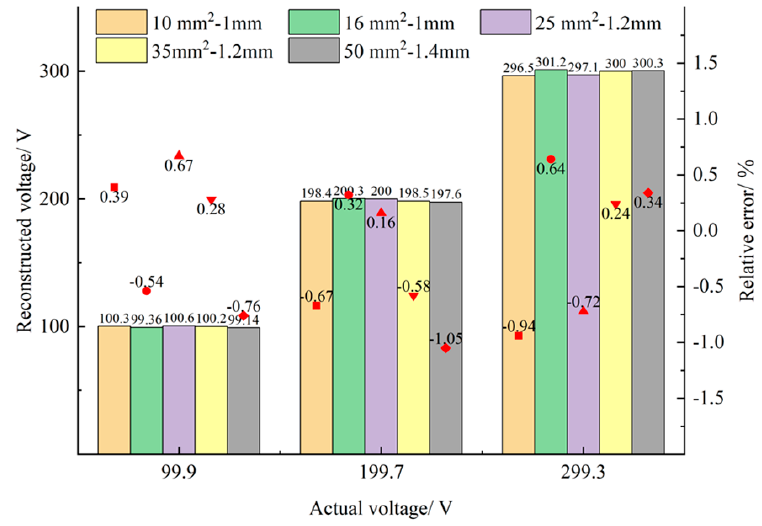
Figure 10. Comparison Diagram of Experiments on Different Types of Circuits.